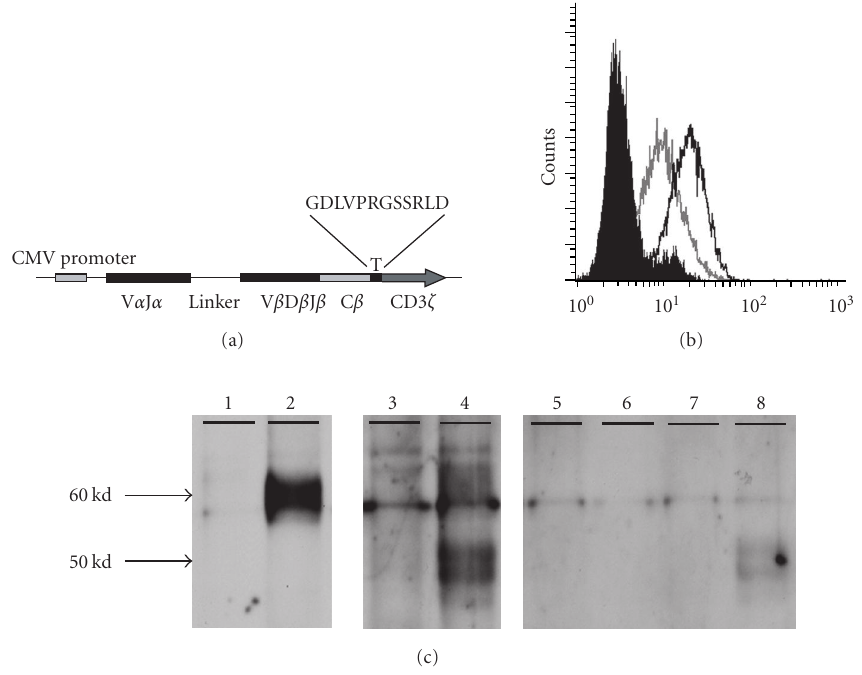
Figure 5: Expression and purification of soluble scTR following surface biotin labeling and immunoprecipitation . (a) scTR expression vector encoding a thrombin cleavage site, T. (b) RBL cells transfected with the scTR were stained with anti-TR BF1 antibody (open histograms) before (right) or after (left) treatment with thrombin. Filled histogram shows staining with isotype control antibody. (c) Immunoprecipita- tion of the scTR from RBL (lanes 1 and 3) or RBL cells transfected with the scTR (lanes 2 and 4) before (lanes 1 and 2) or after (lanes 3 and 4) treatment with thrombin. Lanes 6–8 are SA-HRP blotting of fraction eluted with 150 mM Glycine, PH 2.2, 100mM Glycine PH 2.2, or diethylamine (DEA) PH 11.2, respectively. Lane 5 is IP from control